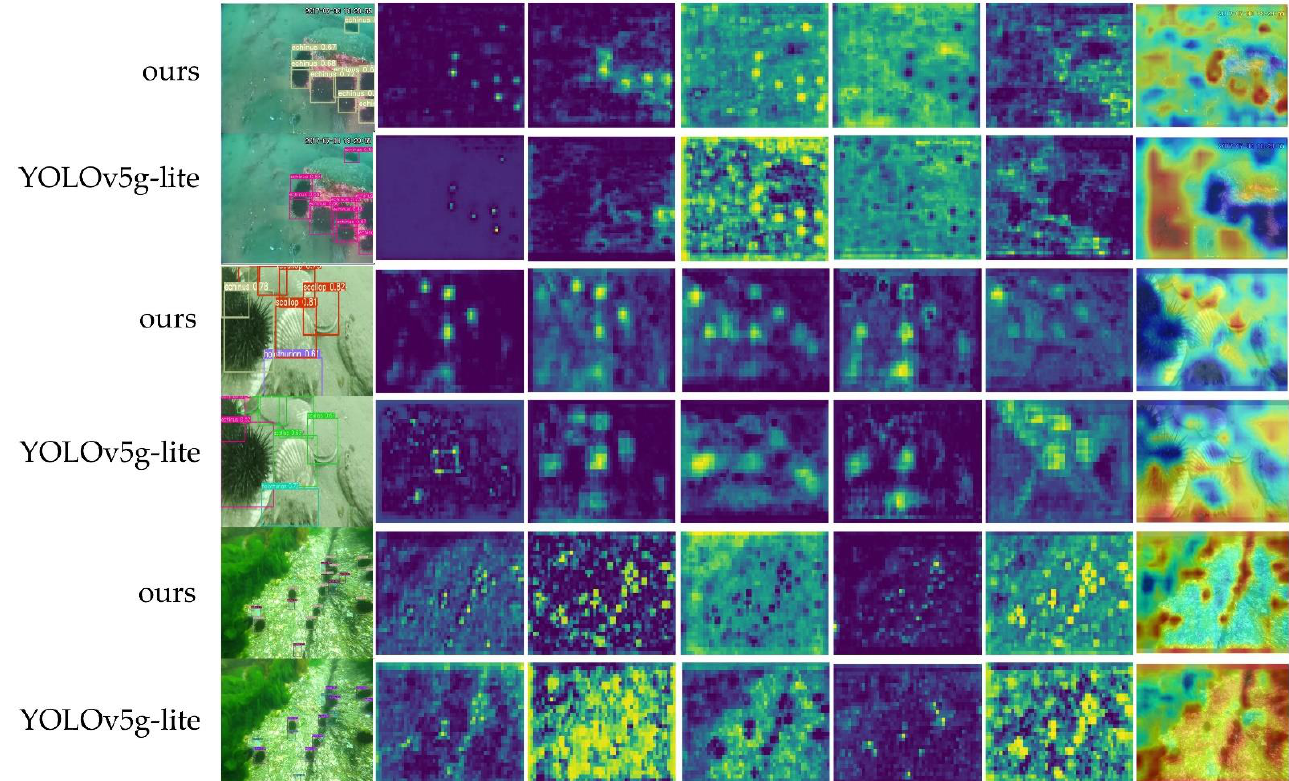
Figure 9. Detection effect visualization, feature visualization and attention visualization results.